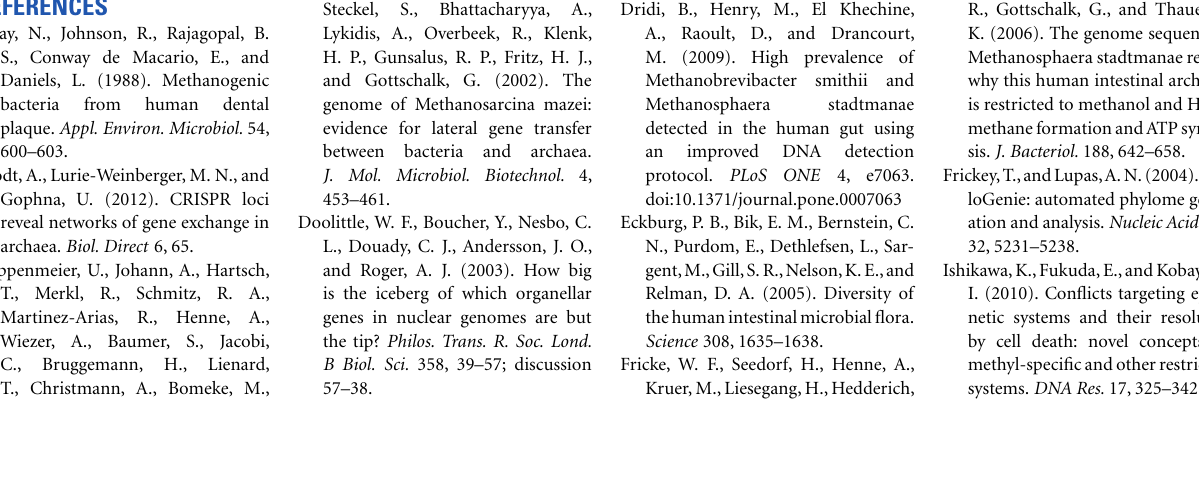
Table S5 |All COGs gained and lost in the three mammalian-associated methanogens (Node_11) compared to the its progenitor node (node_13). Table S6 |All COGs gained and lost in M. stadtmanae compared to the ancestor of the three mammalian associated methanogens (Node_11). Table S7 |All COGs gained and lost in the three mammalian associated methanogens (Node_11) compared to the “ancestral” methanogen